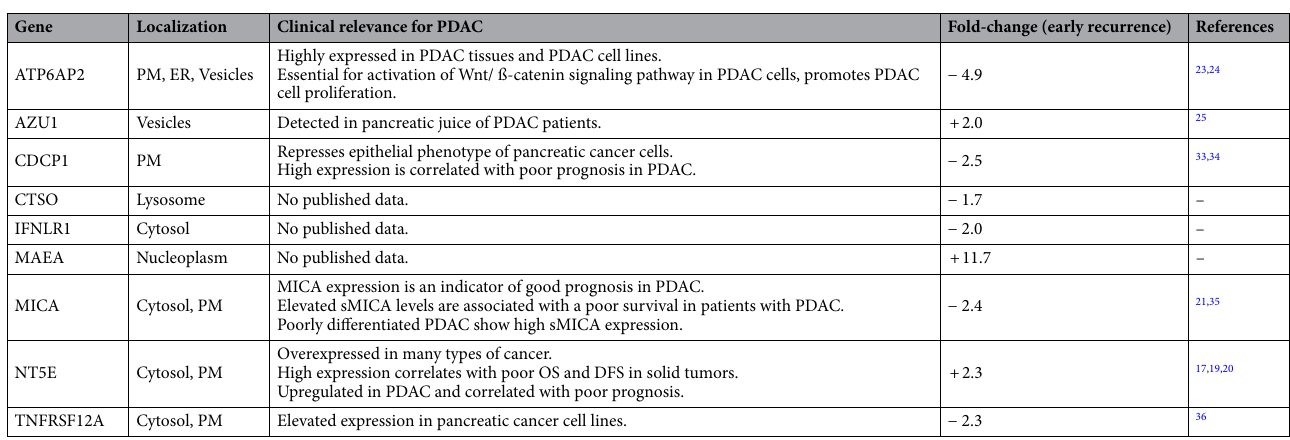
Table 3. Summary of characteristics of potential biomarkers indicating early recurrence of PDAC following resection. PM : plasma membrane; OS : overall survival; DFS : disease-free